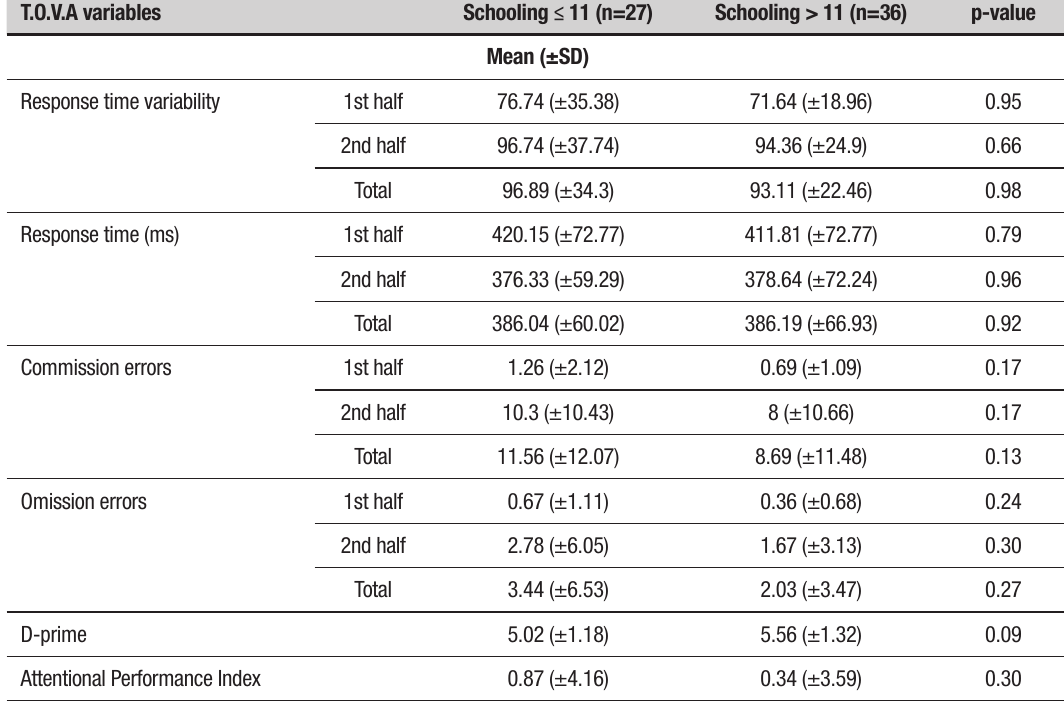
Table 4. Performance on T.O.V.A variables by educational level (n=63).